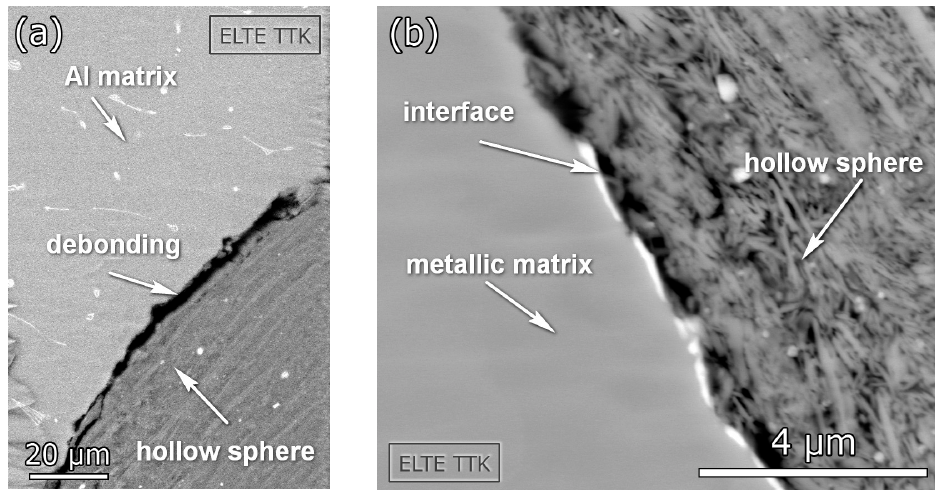
Figure 5. SEM micrographs showing ( a ) debonding of ceramic spheres from the Al matrix and ( b ) layered structure of the ceramic spheres.